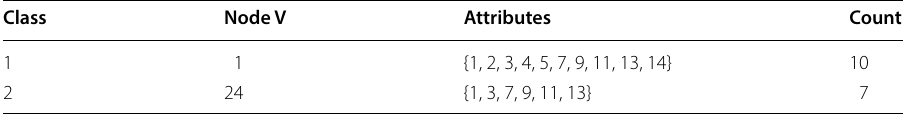
Table 5 Attribute Index Structure for Karate-club